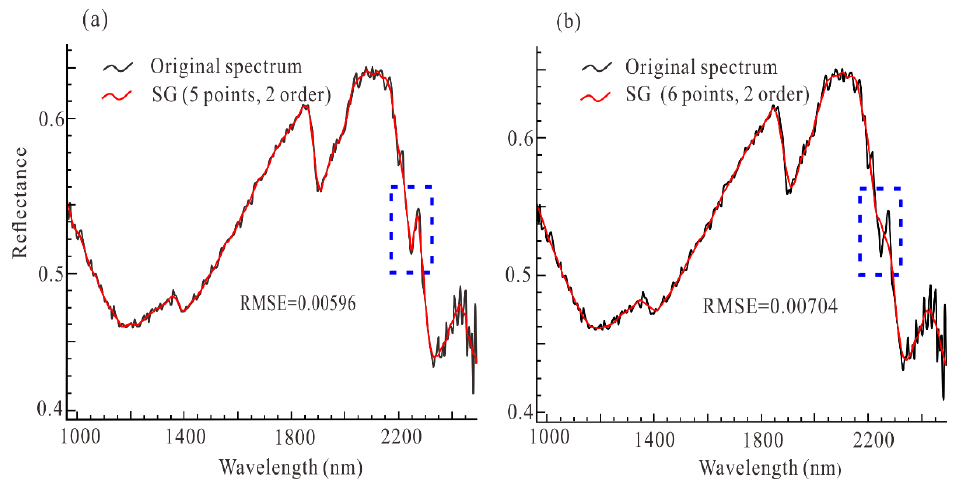
Figure 9. The results of Savitzky–Golay filtering: ( a ) smooth result of 5 points and 2 order and ( b ) smooth result of 6 points and 2 order. A larger window will minimize the subtle spectral features (blue box).